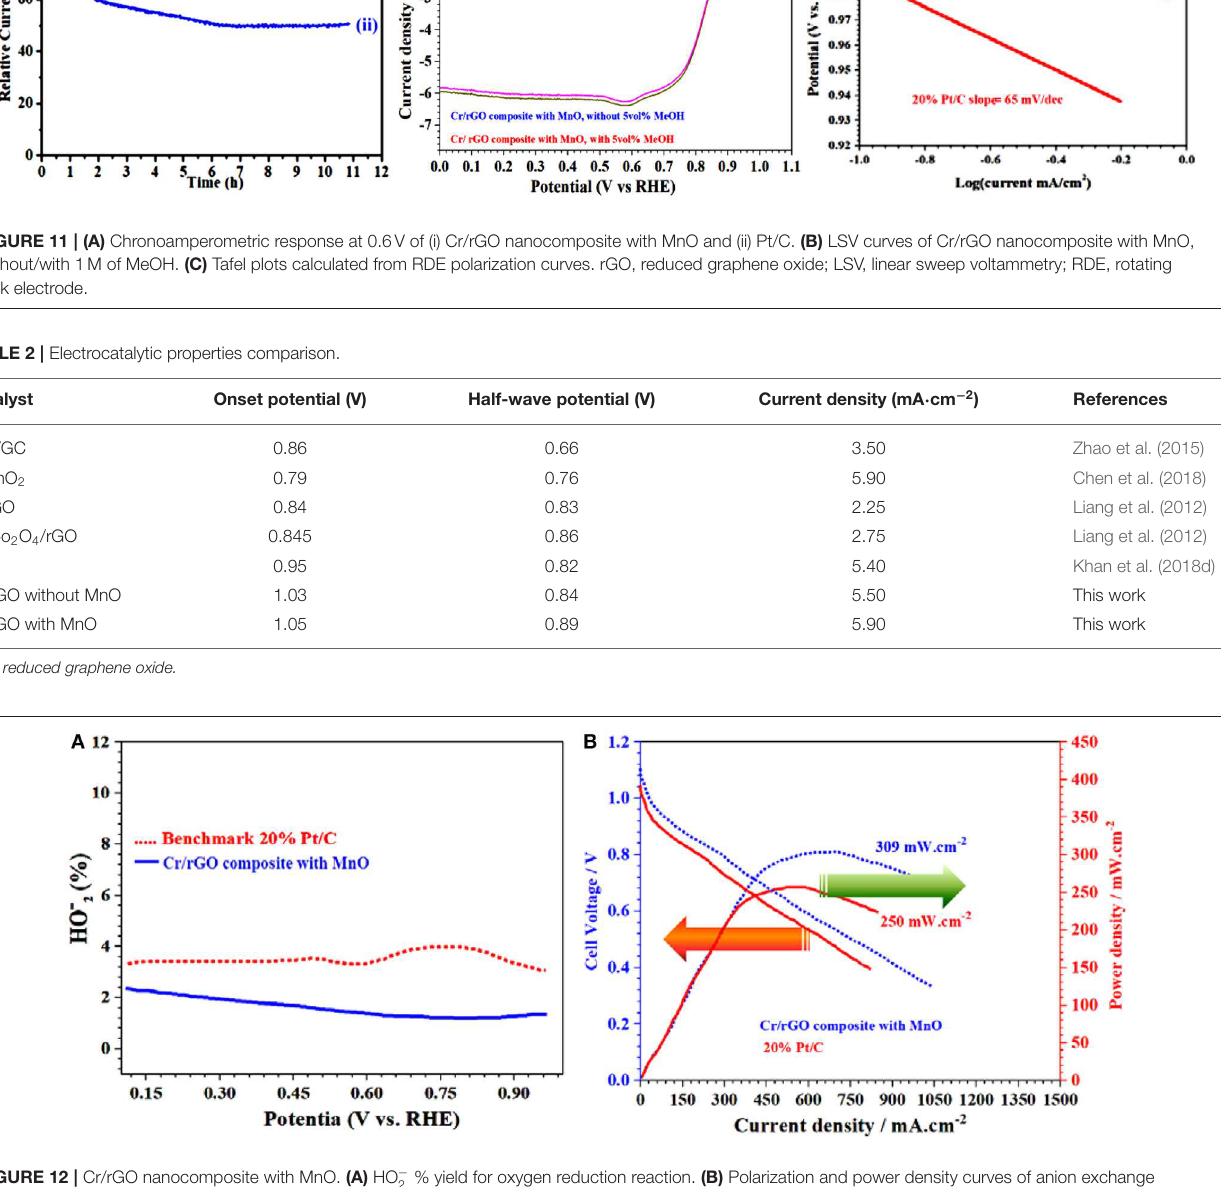
synthesized Cr/rGO composite with MnO, before and